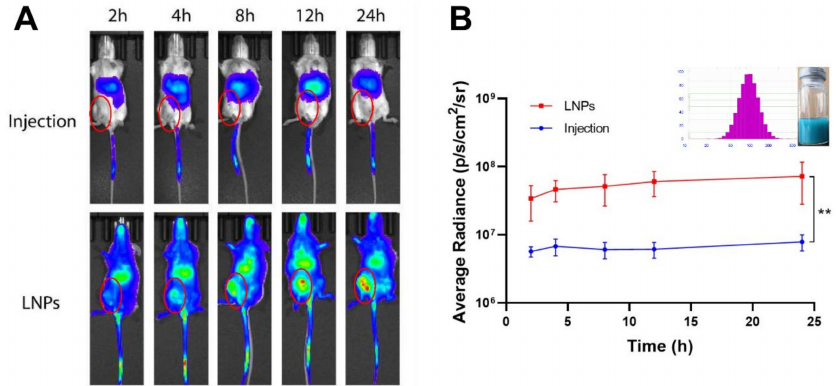
Figure 11. Breast cancer targeted efficacy of LNPs in 4T1 orthotropic mice. Notes: ( A ) in vivo fluorescence signal changes of the 4T1 tumor-bearing mice as the time passed after intravenous injection of normal DiR injection or DiR-LNPs; ( B ) quantitative image analysis of the inten- sity of light emitted from tumor sites ( n = 3). Abbreviations: DiR, 1,1 (cid:48) -dioctadecyl-3,3,3 (cid:48) ,3 (cid:48) - tetramethylindotricarbocyanine iodide; PTX, Paclitaxel; LNPs, lipid nanoparticles. Significant differ- ences are indicated: ** p <